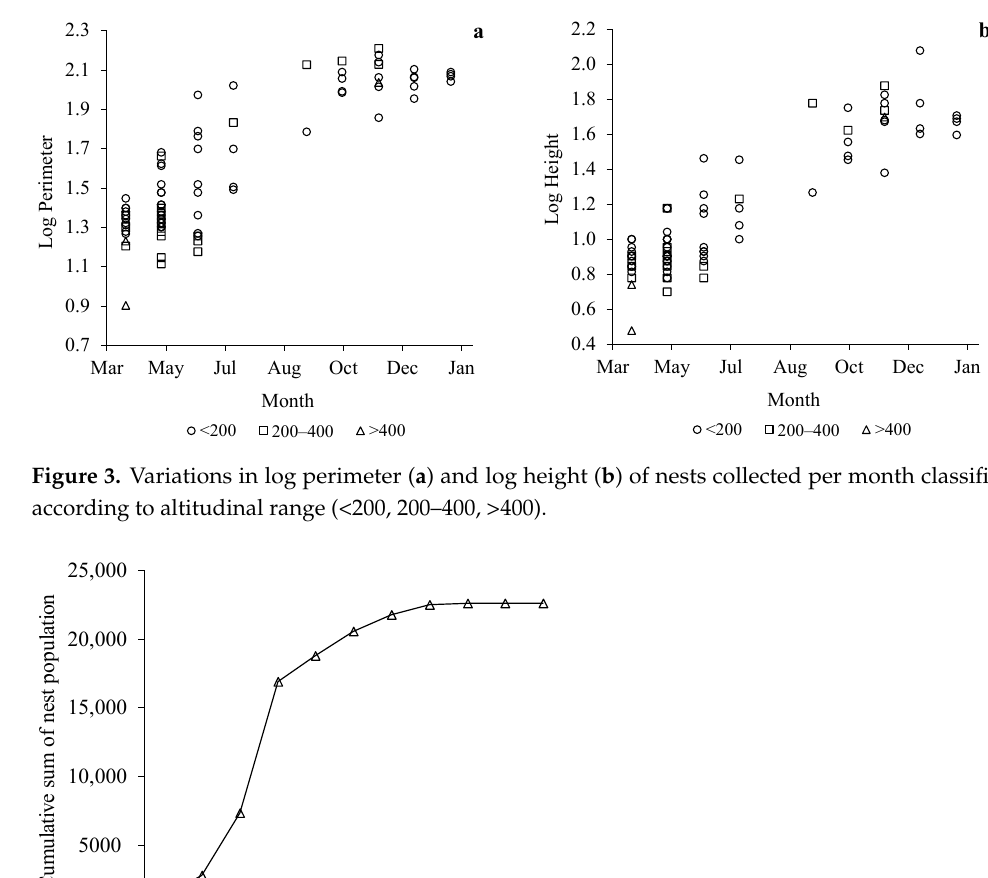
Figure 3. Variations in log perimeter ( a ) and log height ( b ) of nests collected per month classified according to altitudinal range (<200, 200–400, >400).